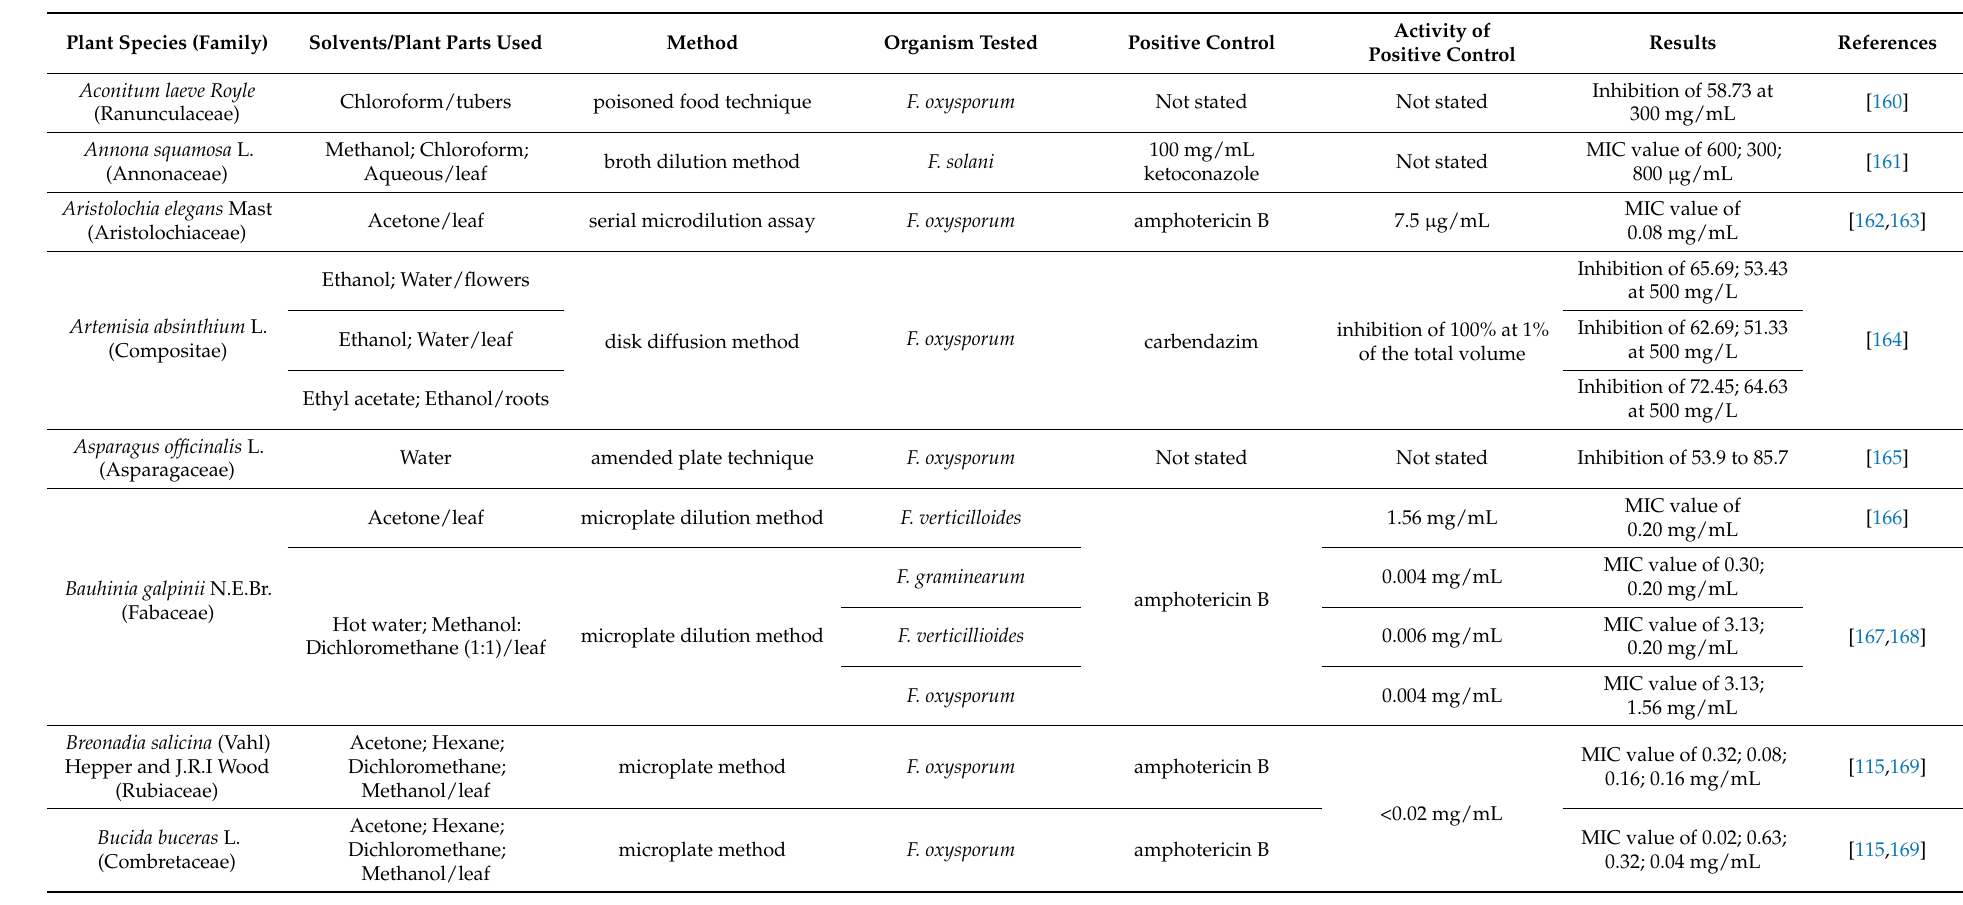
Table 2. Medicinal plants evaluated for antifungal activity against Fusarium phytopathogenic species. The plant extracts were evaluated using different screening methods/assays, and their antifungal activities were reported in terms of minimum inhibitory concentration (MIC) or percentage inhibition